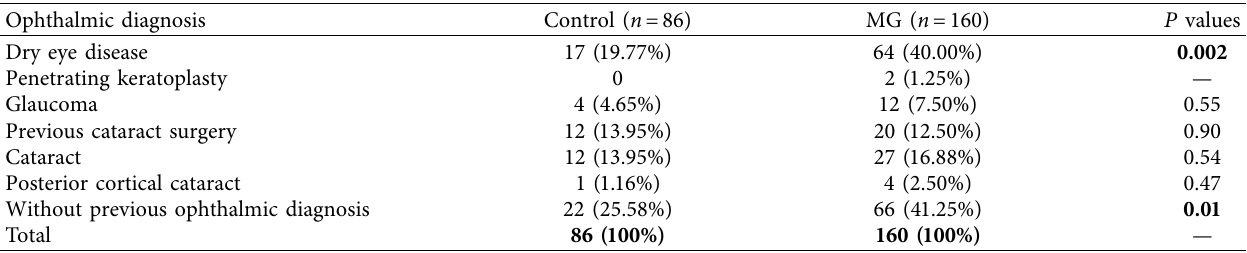
Table 2: Ophthalmic diagnosis in ophthalmic history of control subjects and in patients with monoclonal gammopathy (MG). Ophthalmic diagnosis